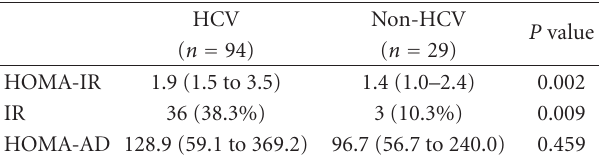
Table 2: IR profile in HCV and non-HCV individuals according to HOMA-IR and HOMA-AD.